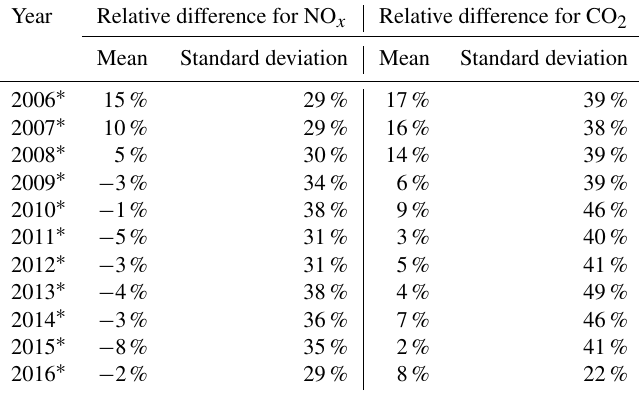
), bottom-up NO x emissions ( E CEMS ), satellite- NO x NO x ) for eight US power plants during May to September from 2005 to CO 2